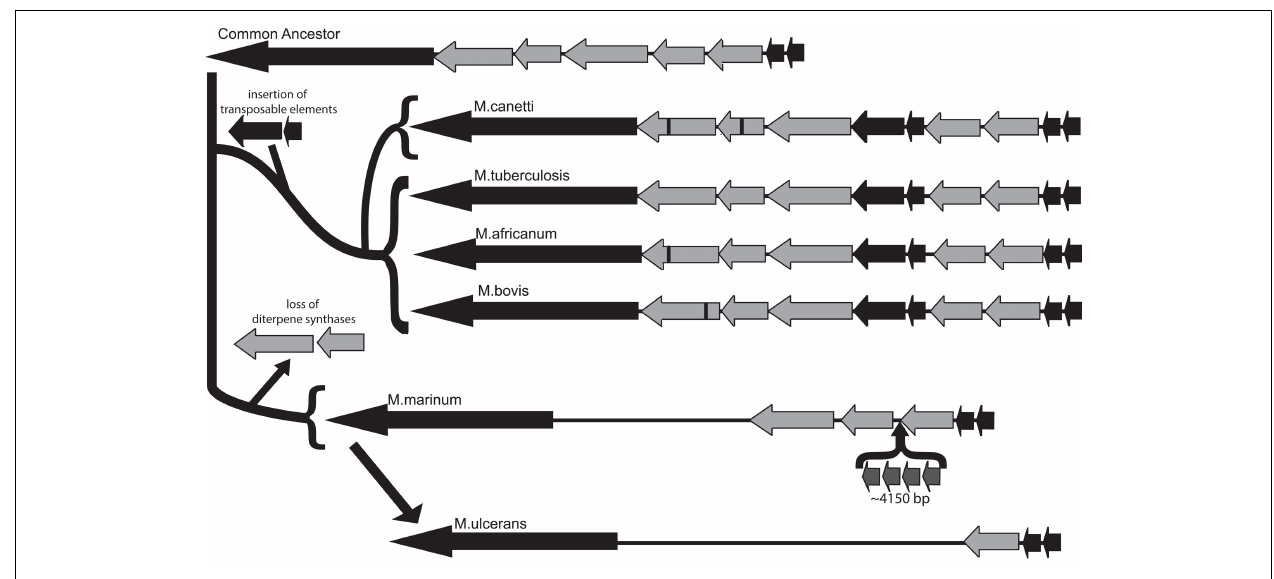
synthases (black bars). Further, following separation of M. marinum and the MTC, the diterpene synthases were lost from M. marinum and several genes inserted, thus disrupting the operon. During later reductive speciation leading to M. ulcerans , two of the remaining genes were lost, leaving only the homolog to Rv3383c and flanking segments of the genome. Notably, retention of fully functional diterpene synthase encoding genes (Rv3377c and Rv3378c) is only found in the human-specific pathogen Mtb